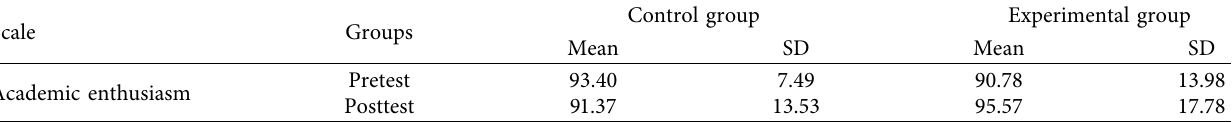
Table 1: Mean and standard deviation (SD) of academic enthusiasm in the experimental and control groups.